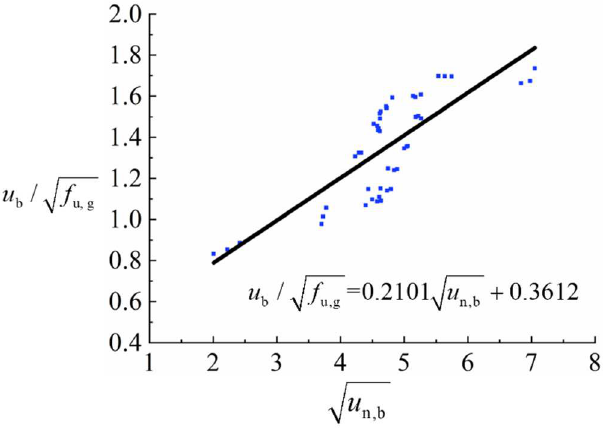
√ u n , b u . Figure 17. Fitting curve of u b / , nb